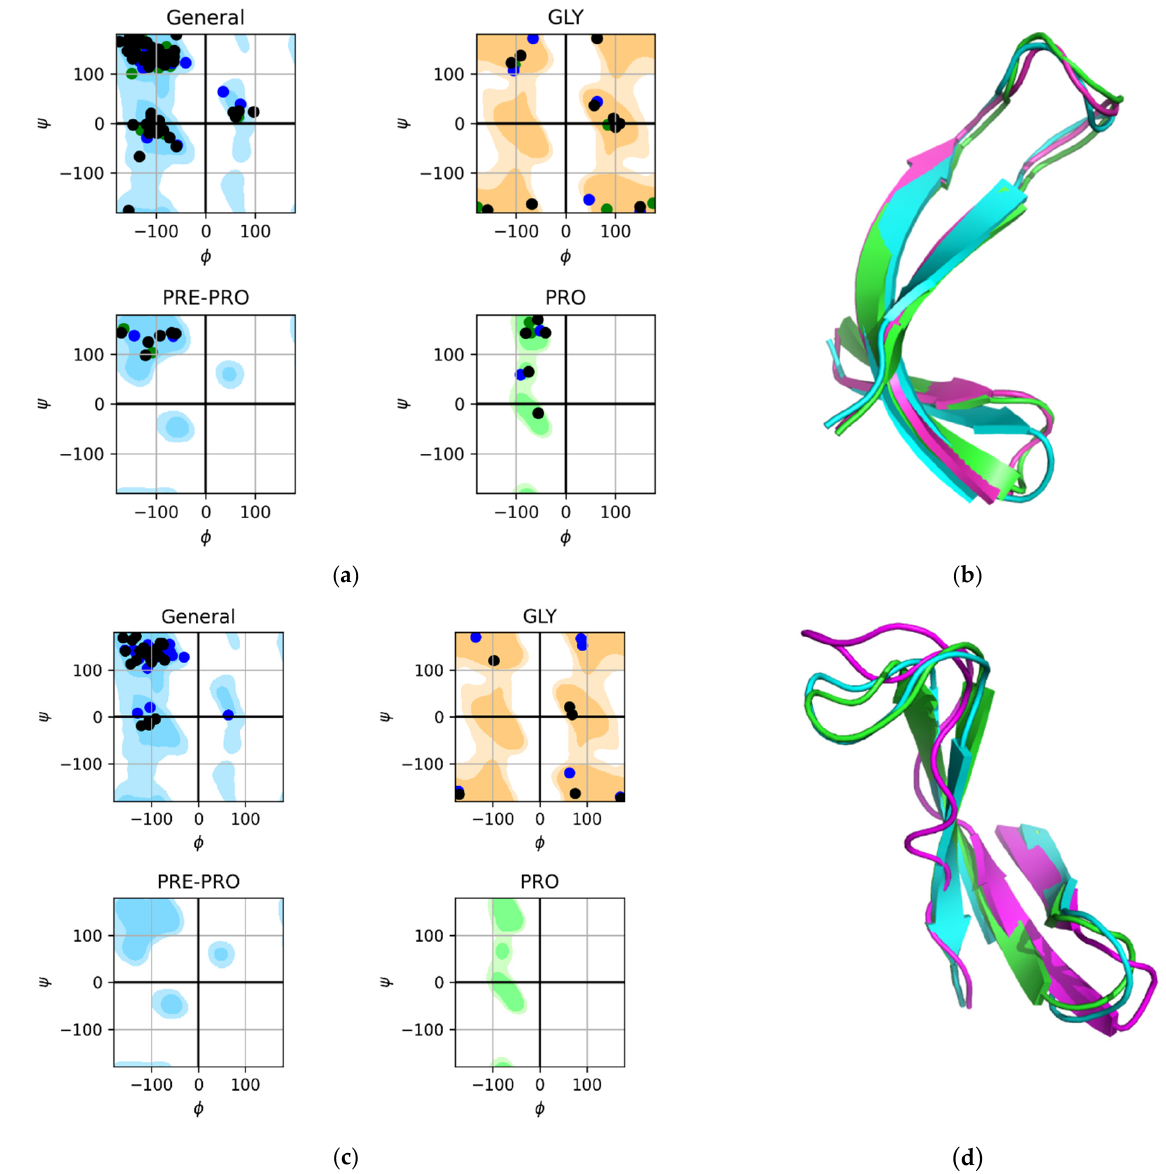
Figure 2. Distribution of angles ϕ and ψ on the Ramachandran map of the studied amino acid residues of the 3 β -corners of 2E3H, chain A, region: 216–246 and 2E3I, chain A, region: A62–A93 during the MD experiment. The calculated angles are highlighted: for the initial structure, in yellow; the angles for the major cluster of the 3 β -corner in the protein composition, in green; and the angles for the major cluster of the 3 β -corner that participated autonomously in the experiment, in black. ( a ) Ramachandran map for all amino acid residues (except for amino acids highlighted on a separate map) and glycine GLY for 2E3H. ( b ) Schematic representation of the 2E3I of the original motif (green), the major cluster of the 3 β -corner within the protein (red), and the major cluster of the 3 β -corner that participated autonomously in the experiment (grey). ( c ) Ramachandran map for all amino acid residues. GLY, amino acid before proline; Pre-PRO, proline PRO for 2E3H. ( d ) Schematic representation of the 2E3I of the motif (green), the major cluster of the 3 β -corner within the protein (red), and the major cluster of the 3 β -corner that participated autonomously in the experiment